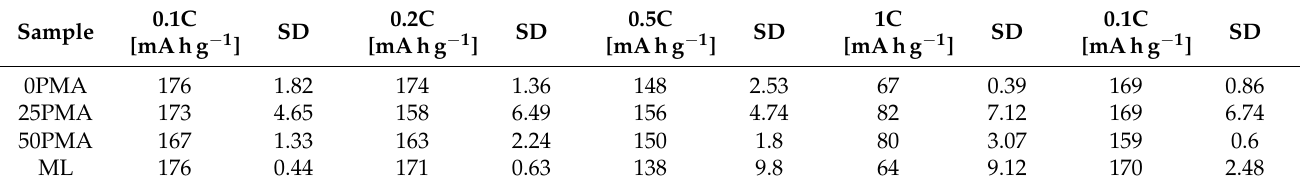
Figure 3. ( a ) Rate capability test including ML samples from a previous study [8] and ( b ) results of 100 cycles at 0.2C. A plot including error bars is attached to the Appendix (Figure A5). Table 3. Specific discharge capacities [mAhg − 1 ] for different C-rates of all tested samples, including ML samples as reference [8]. Results are averaged over all cycles of the specific C-rate and standard deviations (SD) calculated.